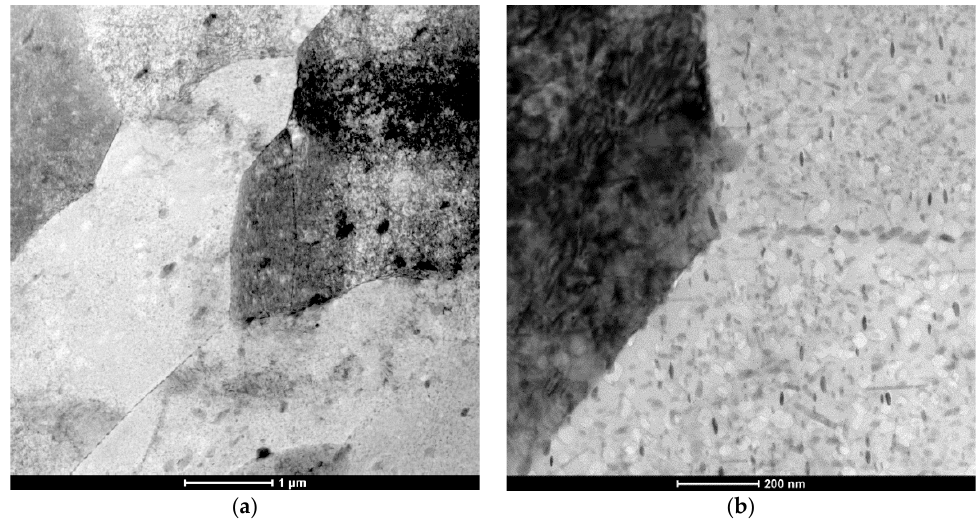
Figure 4. ( a ) Matrix of α solution with non -uniformly distributed precipitates; ( b ) Indistinct